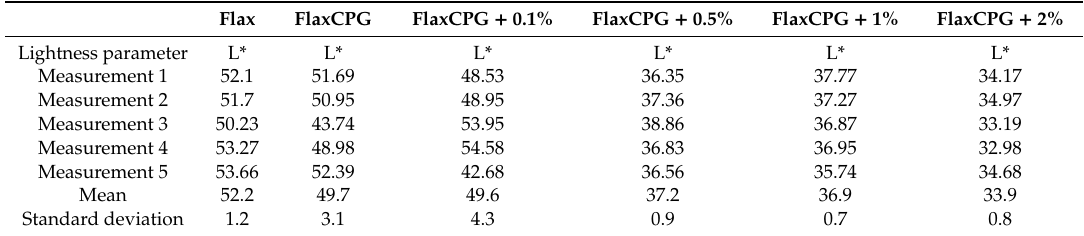
Table 1. Cielab lightness coordinates measured in five di ff erent sites of each sample under